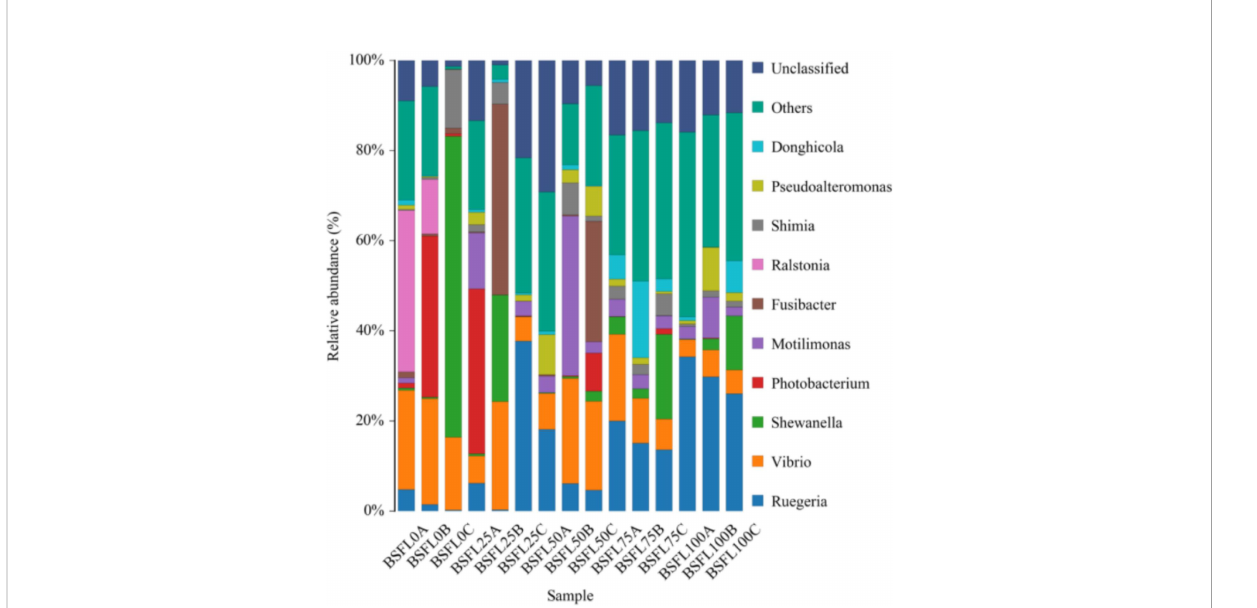
FIGURE 6 Relative abundances of bacterial genera in the intestine of L. vannamei fed with diets having different levels of BSFL. The most dominant genera (> 1% of the total sequences) are shown in the schematic individually, and the relative abundances of main genera is indicated in Table